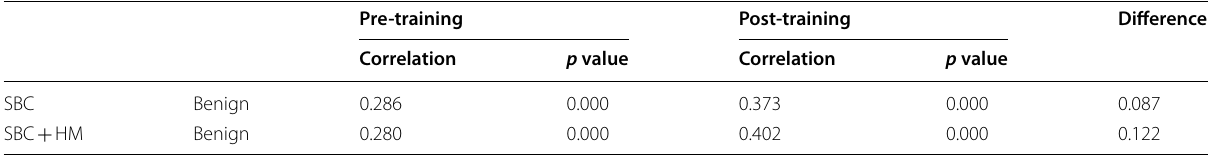
Table 7 Spearman’s rank correlations between the average human learner score pre‑ and post‑training, and the SBC/SBC probabilities of benign abnormality